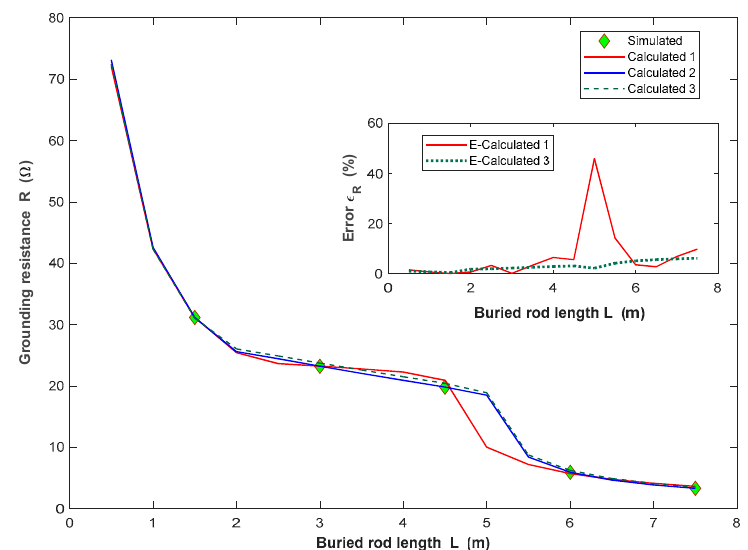
Figure 5. Simulated and calculated grounding resistance. If the grounding resistance is now measured every time 0.5 m of rod driven into the ground, new data have to be added to Table 2 obtaining Table 3. Table 3. Buried rod length L (m) and the corresponding grounding resistance R ( Ω ).